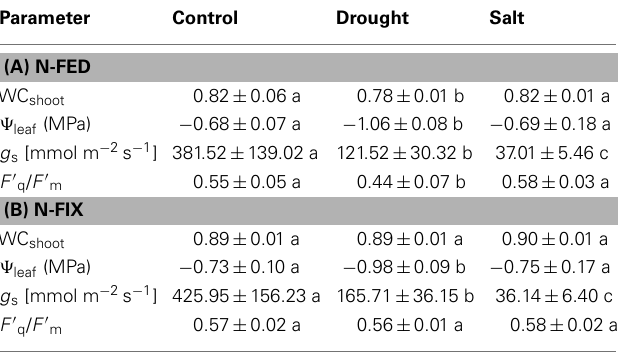
Values represent the mean ± SE (n = 3).The letters a, b, and c indicate significant differences between control and stress treatments (Student’s t test p < 0.05). WC, water content; Ψ leaf , leaf water potential; g s , stomatal conductance; F (cid:48) q /F (cid:48) m , PSII operating